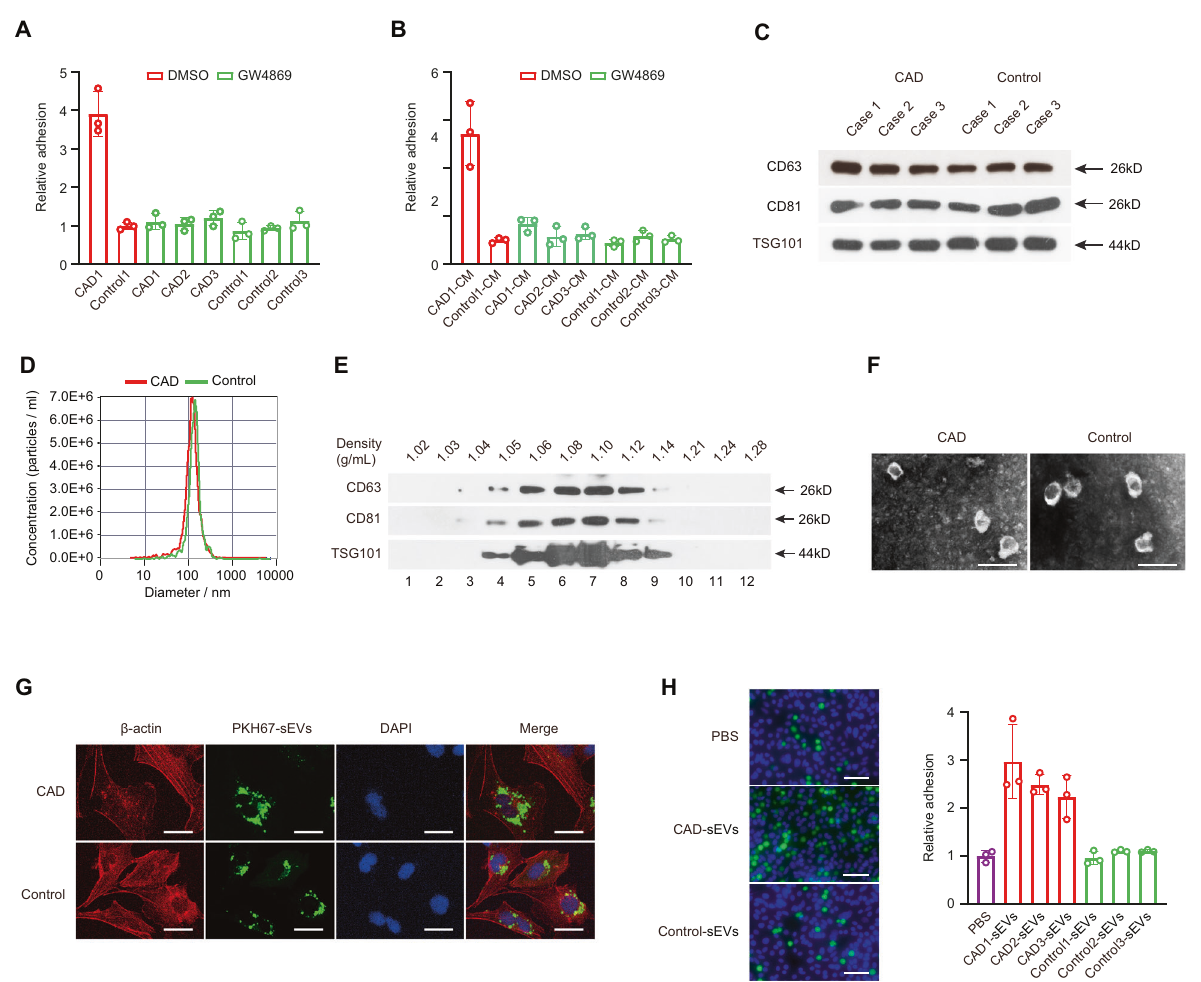
Fig. 2 sEVs from monocytes of CAD patients promoted heterogeneous adhesion. Heterogeneous adhesion ability of monocytes to HCAECs was analyzed using monocytes ( A ) or monocytes culture medium (CM) ( B ) following GW4869 exposure. sEVs from monocytes were extracted to be veri fi ed using western blot assay ( C ) and the NTA method ( D ). CD63, CD81, and TSG101 expression were detected in fractions collected from OptiPrep TM density gradient centrifugation using western blot assay ( E ). sEVs obtained from fraction 7 (density 1.10 g/mL) was veri fi ed using transmission electron microscopy ( F ). Scale bar = 200 nm. G HCAECs were incubated directly with sEVs from CAD patients or control- related monocytes. Scale bar = 20 µm. H Heterogeneous adhesion ability of monocytes to HCAECs was analyzed using CAD-sEVs or Control- sEVs. Scale bar = 20 µm. Data are presented as means ± SD; a signi fi cant difference was identi fi ed with Student ’ s t test. * P < 0.05; ** P < 0.01; ns (not signi fi